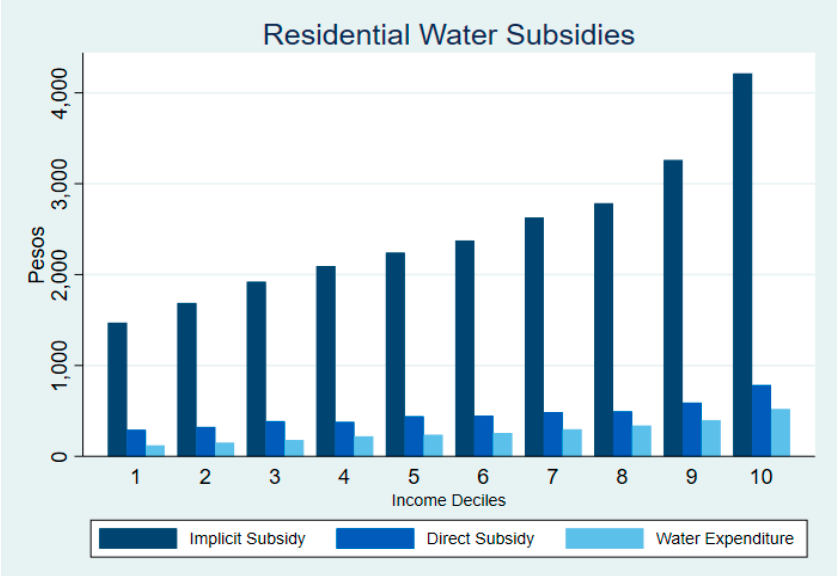
Figure 8. Residential water subsidies, 2014. Note: Implicit subsidy is accounted as the economic subsidy. Source: Own Calculations with data from ENIGH [25]; and PIGOO [27].